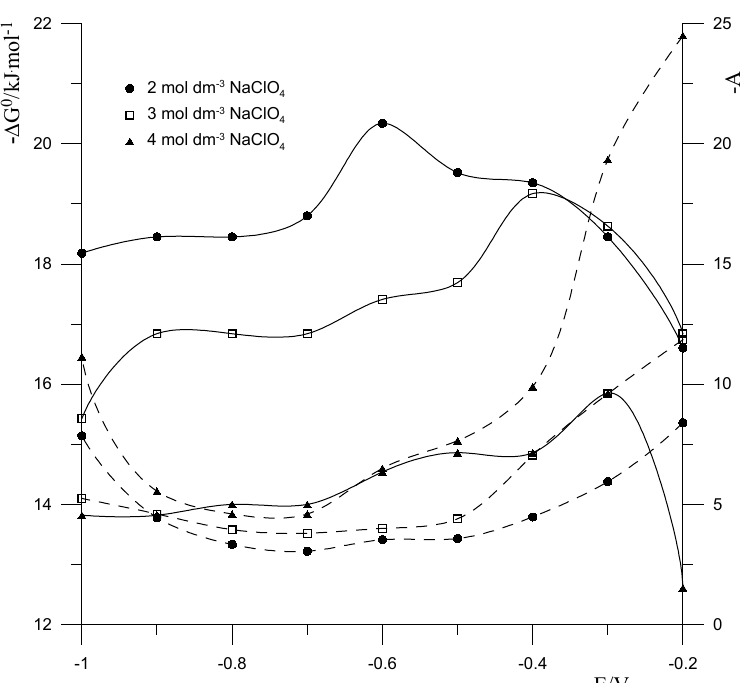
Figure 5. Variation of the Gibbs energy of adsorption D G 0 (solid lines) and the interaction parameter A (dashed lines) due to electrode potential and NaClO concentration for tert -butanol derived from the Frumkin isotherm. 4